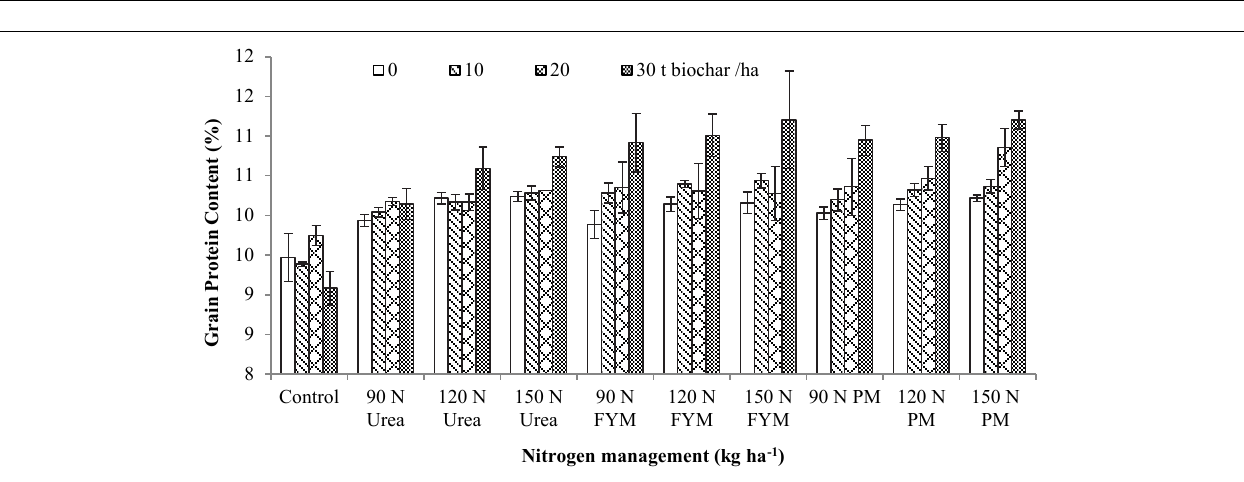
FIGURE 6 | Interactive effect of biochar and N levels applied from different sources on total nitrogen of wheat. Bars on graph denote SE of mean ( n = 3). FYM, farmyard manure; PM, poultry manure.